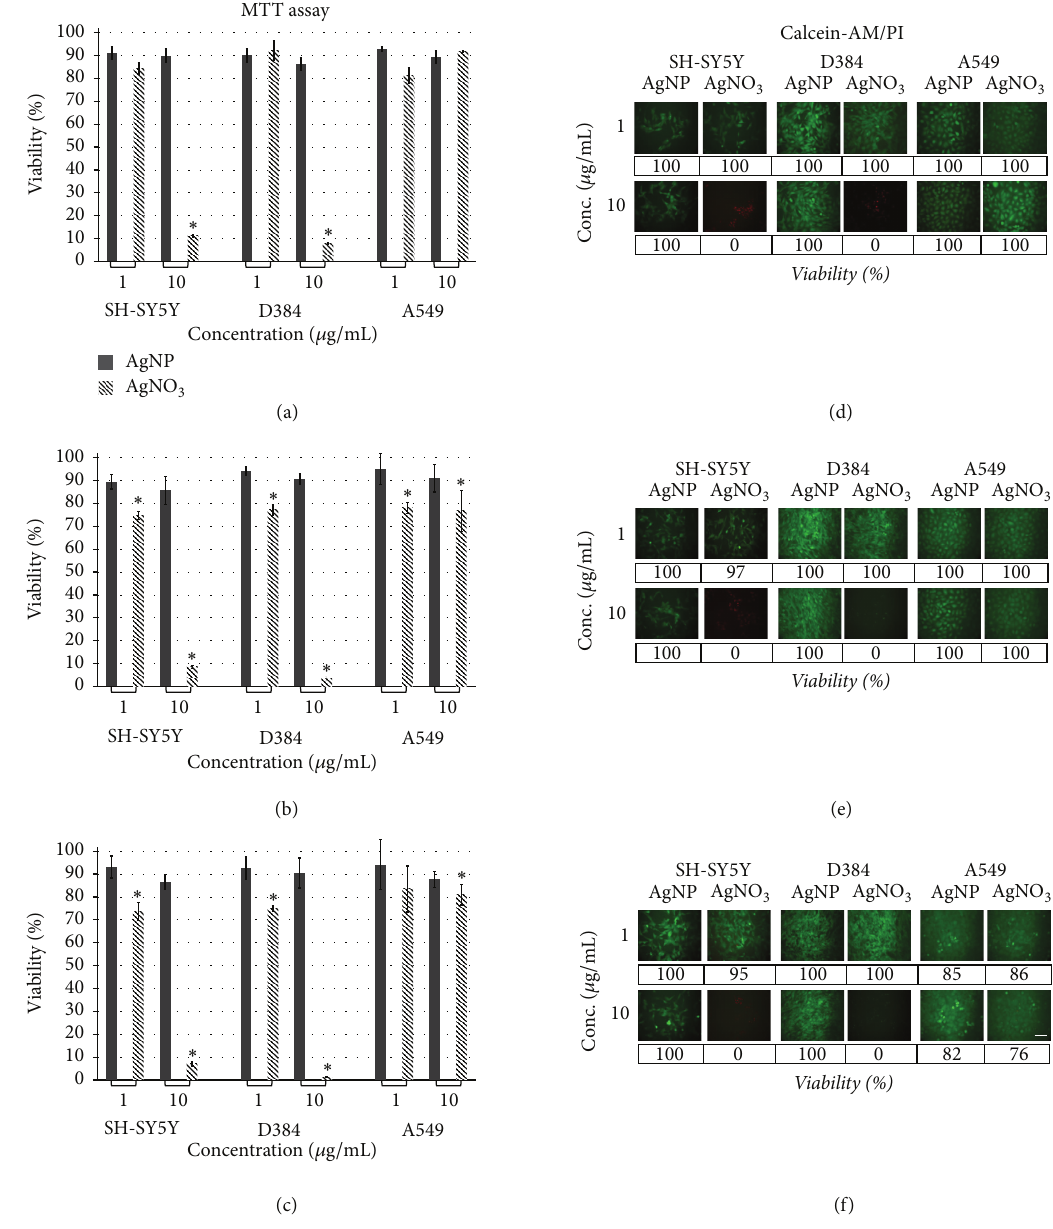
Figure 2: Data comparisons between AgNPs and AgNO 3 in SH-SY5Y, D384 and A549 cell lines. Panels (a), (b), and (c) show mitochondrial function evaluation by MTT assay after 4 h, 24h and 48 h exposure to 1 and 10 𝜇 g/ml of AgNPs and AgNO 3 . ∗ Different from control in each cell line 𝑃 < 0.05 , statistical analysis by ANOVA followed by Tukey’s test. Error bars indicate S.D. Panels (d), (e), and (f) show membrane integrity by calcein-AM/Propidium Iodide staining after 4 h, 24 h and 48 h exposure to 1 and 10 𝜇 g/ml of AgNPs and AgNO 3 ; scale bar 100 𝜇 m. AgNO 3 produced a more pronounced cytotoxic effect to that caused by comparable amount of AgNPs on cerebral cell lines. In A549 cells, similar low cytotoxic profile was observed after both treatment types (AgNPs and AgNO 3